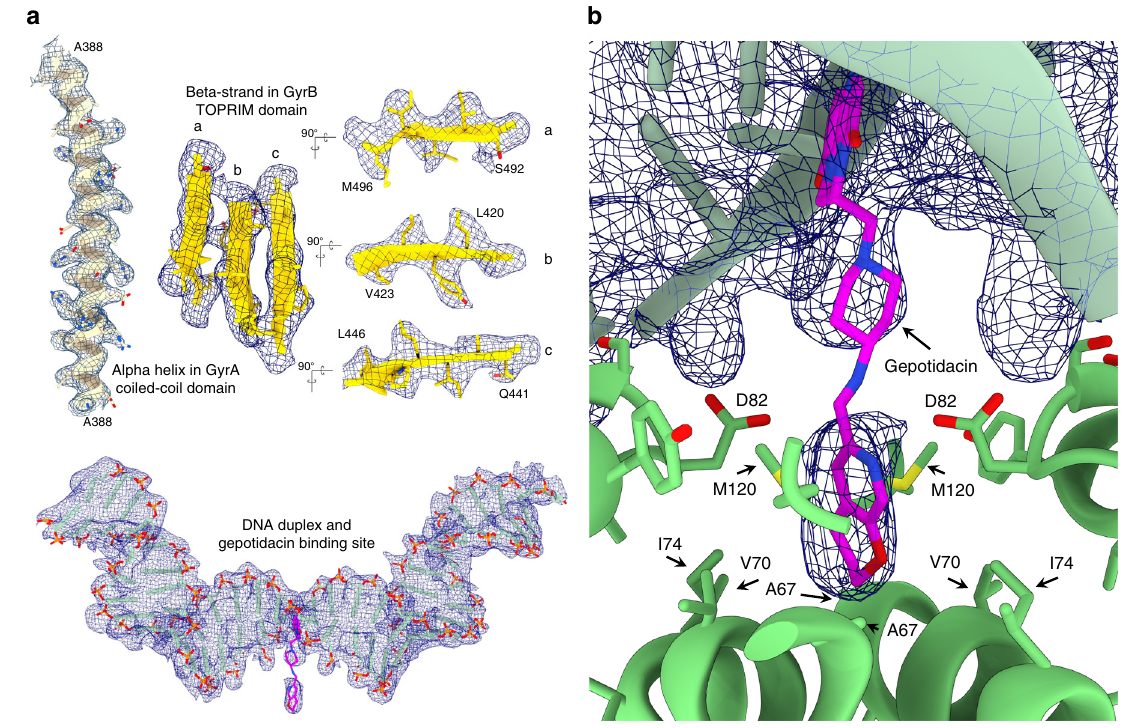
Fig. 6 High-resolution features of the DNA-binding/cleavage domain bound to gepotidacin. a High-resolution features of the 4 Å cryo-EM map. An alpha helix and beta-sheet with well resolved side chains are shown on the upper panel. The 36 bp DNA duplex and gepotidacin are shown in the bottom panel. b Gepotidacin binding site. Electron density of the DNA and gepotidacin are shown in blue mesh. Residues in the direct vicinity of the compound are